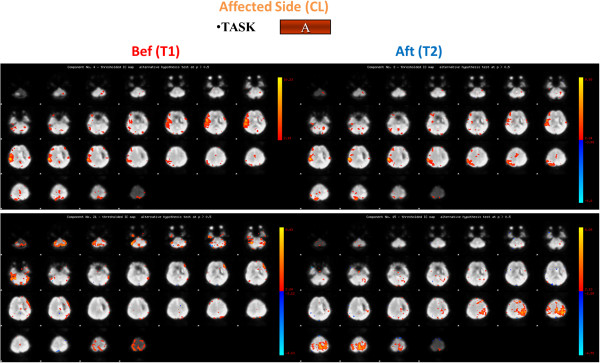
Brain activation maps for the stroke patient: task A, affected side. Brain activation for the Stroke Patient for task A for the affected side (contralateral (CL)) before (Bef) (on the left) and after (Aft) (on the right) the rehabilitation treatment. The four scans are related to the components of interest identified by the PICA Analysis: in this figure on the right the two components identified for the active task (Task A) before the rehabilitation treatment are shown, while on the left right the two components identified for the same task after the rehabilitation treatment are presented.